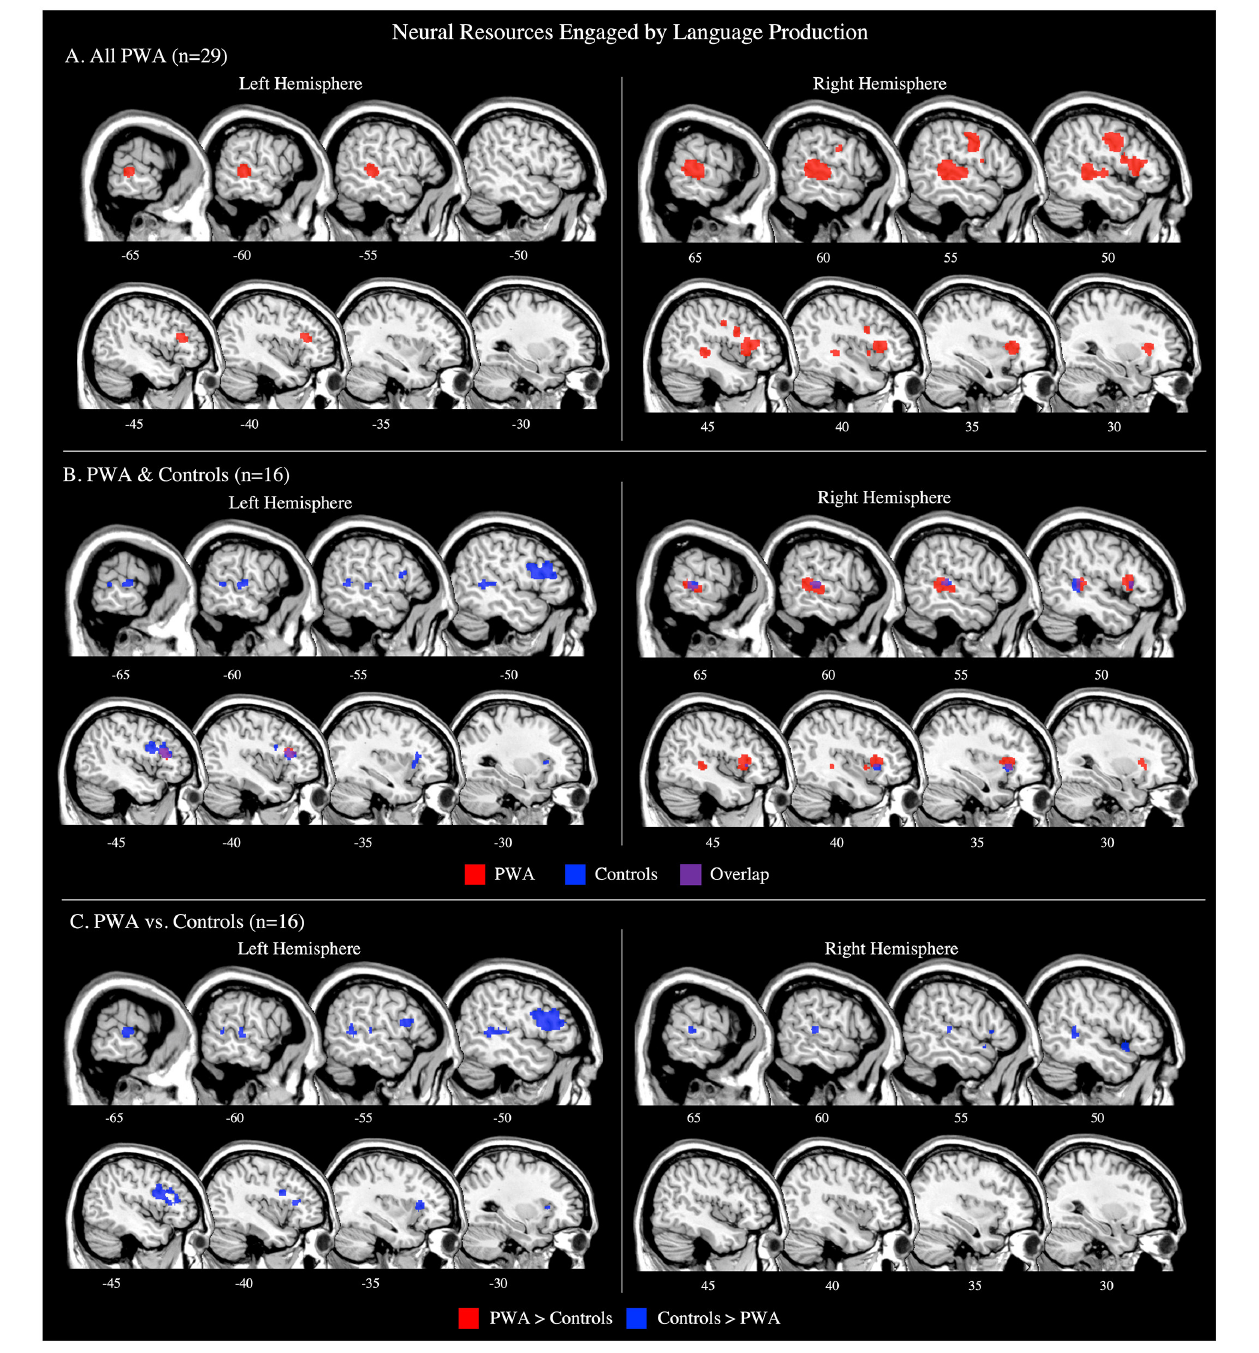
FIGURE 3 | Representative sagittal slices for the language production ALEs in (A) PWA ( p < 0.001 corrected), (B) PWA and controls ( p < 0.001 corrected), and (C) PWA vs. controls ( p = 0.05 uncorrected). (B,C) only include data from tasks which included both PWA and control data. Sample size denotes the number of tasks included in the ALE.